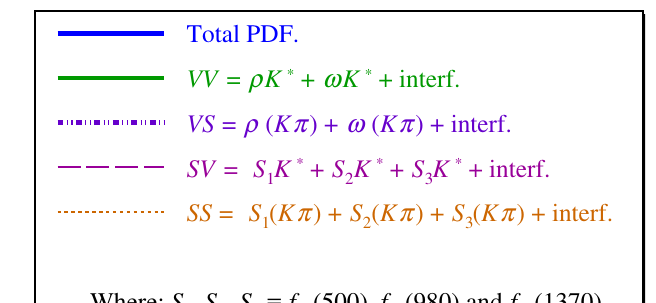
Figure 5. Legend for the plots. The partial waves sharing the same angular dependence are represented as ( V V ) solid green, ( V S ) dash-dotted violet, ( SV ) dashed dark magenta and ( SS ) dotted orange lines. The overall (cid:12)t is shown by a solid blue